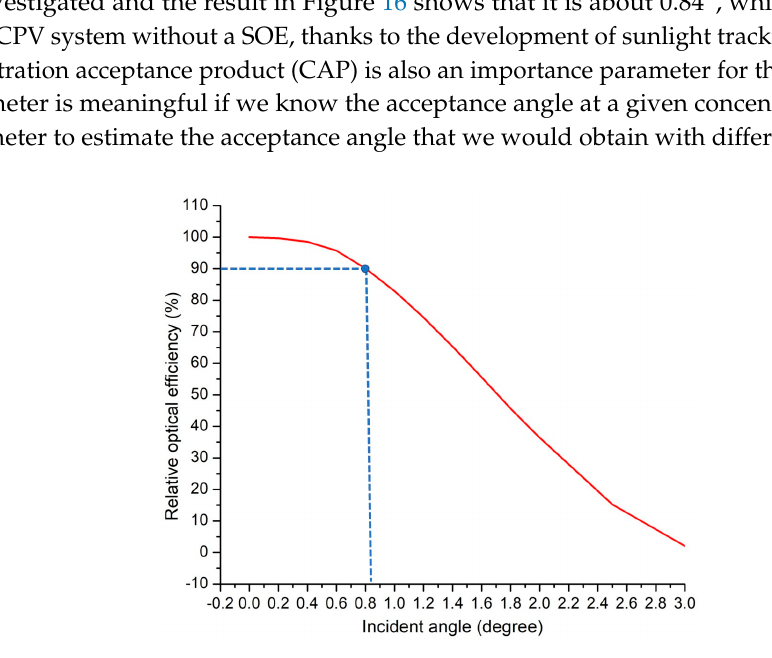
Figure 16. The relative optical efficiency depends on the incident angle of the direct sunlight.